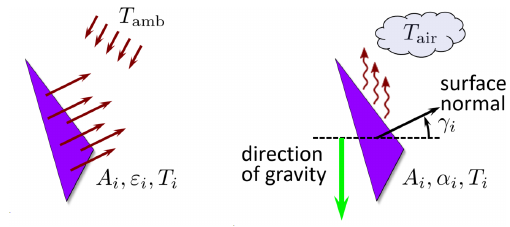
Figure 3. Sketch of the triangle with the parameters for the calcu- lation of the heat flow caused by thermal radiation (left) and natural convection